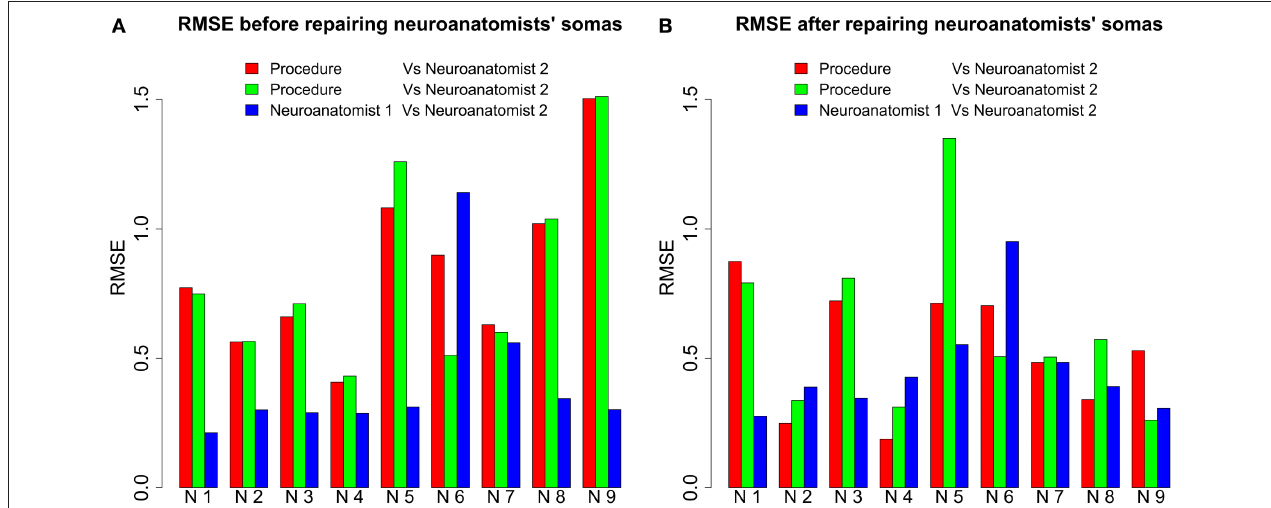
FIGURE 8 | RMSE before and after repairing the neuroanatomists’ somata. (A) For all neurons (each one denoted by N followed by a number) except Neuron 6, RMSE was less between neuroanatomists than between the somata output by our procedure and by either of the neuroanatomists. For several neurons, the difference was actually more than double. (B) The differences between automatically and manually segmented somata were not so remarkable after the repair of the neuroanatomists’ somata. Note that for some neurons RMSE was less between our procedure and the first neuroanatomist than between both neuroanatomists, i.e., the proposed procedure can produce similar cutoffs to a